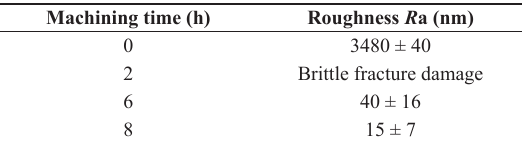
Table 5. Roughness data of sample 6 as a function of the machining time. Machining time (h)